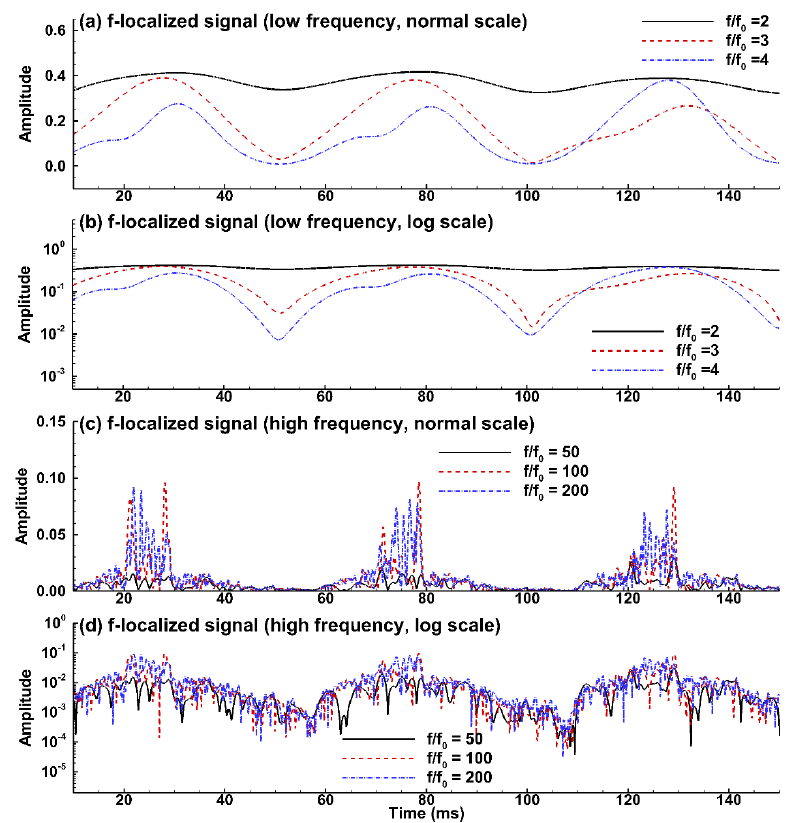
Figure 14. Frequency localization of the acoustic signals generated at the glottal vibration frequency of 20 Hz: f -localized signals that are 2, 3, and 4 times that of the forcing frequency at ( a ) normal scale and ( b ) logarithmical scale, and those that are 50, 100, and 200 times that of the forcing frequency at ( c ) normal and ( d ) logarithmical scale. The amplitude of the first harmonic ( f/f 0 = 2) is higher than all other f -localized signals.